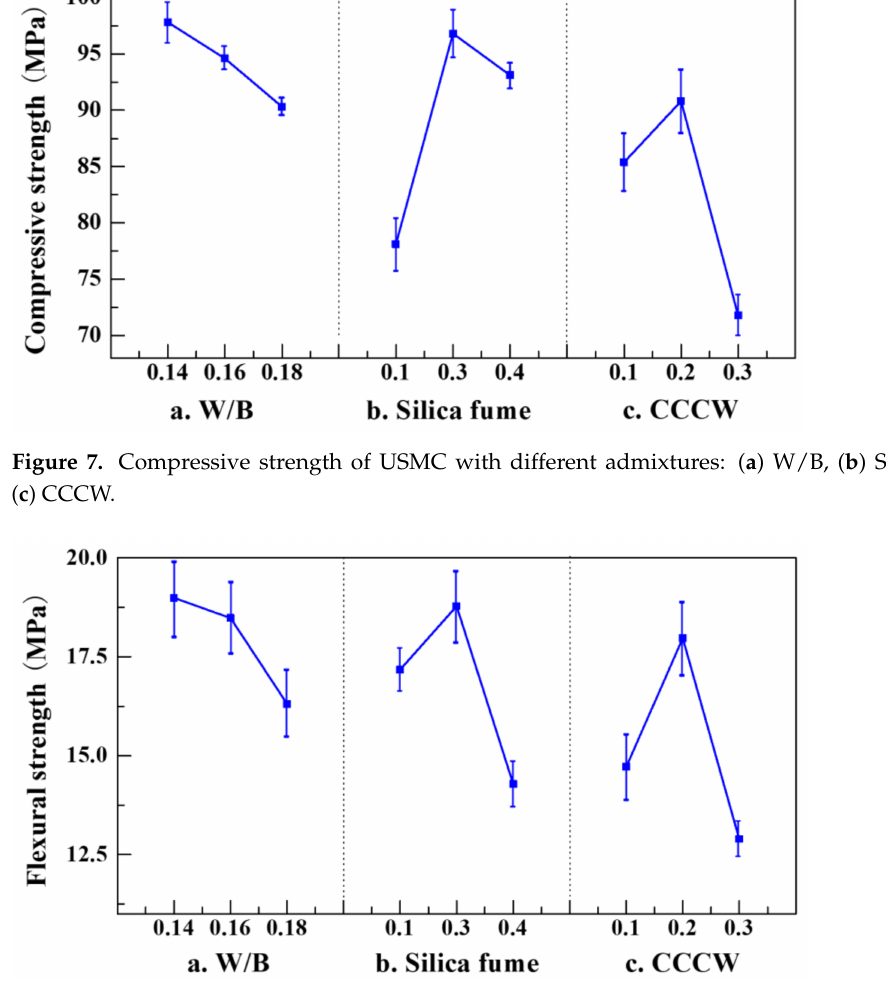
Figure 8. Flexural strength of USMC with different admixtures: ( a ) W/B, ( b ) Silica fume, ( c )